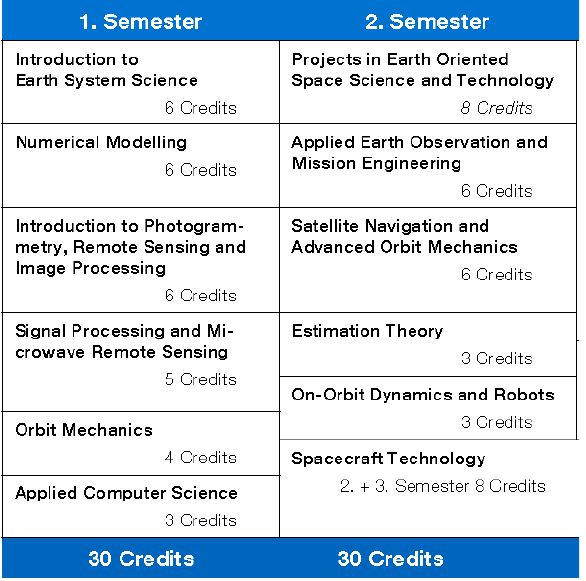
Table 1. Overview of the current ESPACE study plan of the first two semesters showing the modules and the credits..